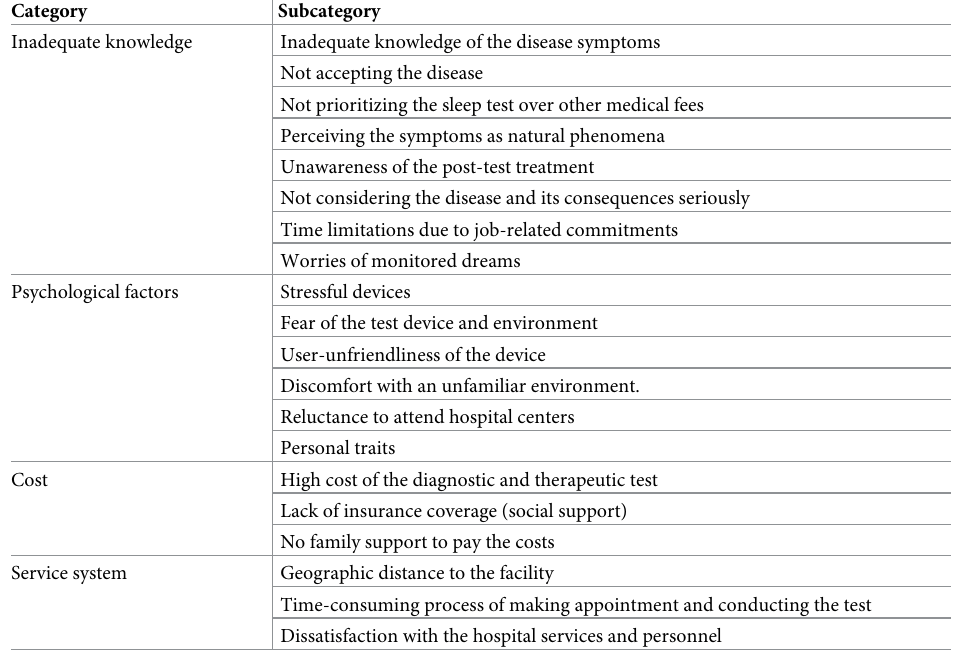
Table 1. Extracted categories and subcategories from the in-depth semi-structured